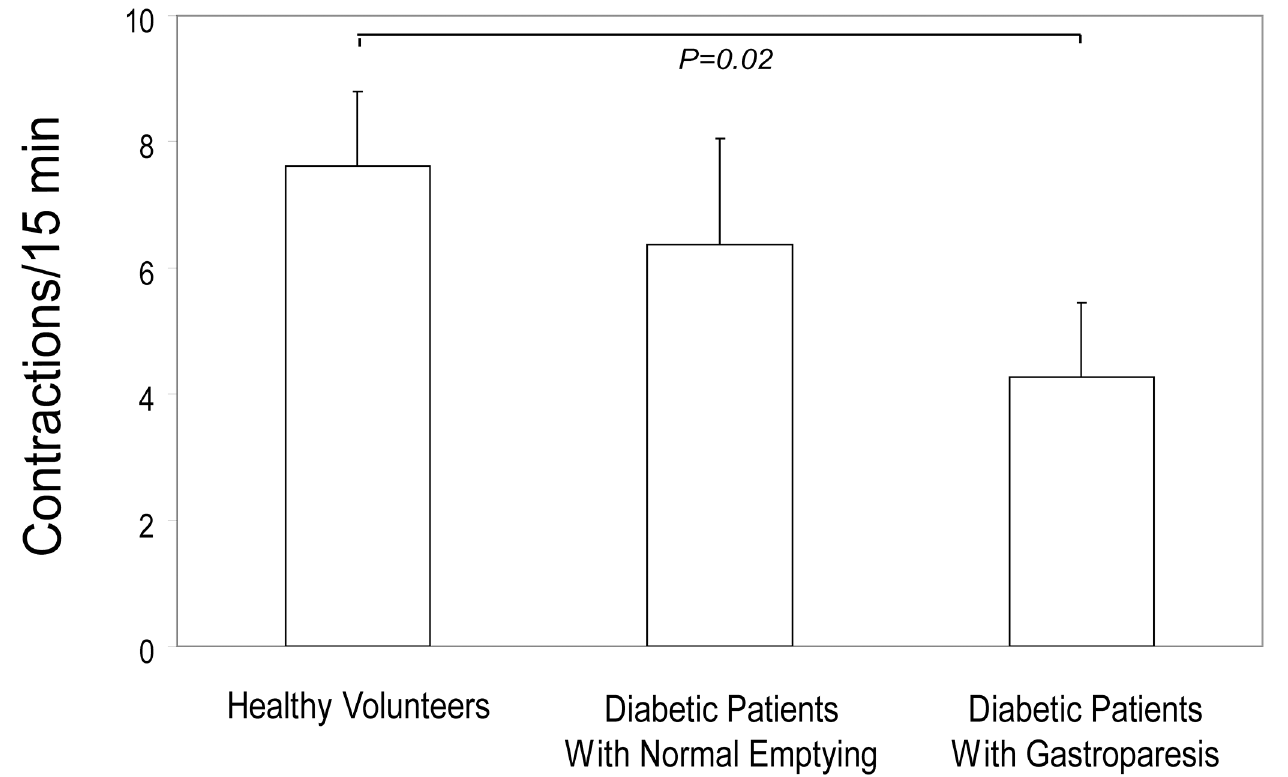
Fig 3. Numbers of Colon Contractions. Overall numbers of colon contractions are plotted for the three groups. Diabetics with gastroparesis showed reductions in overall numbers of contractions compared to healthy subjects (P = 0.02). Overall contractions in diabetics with normal gastric emptying were not different than in diabetic patients with gastroparesis or in healthy controls (P =